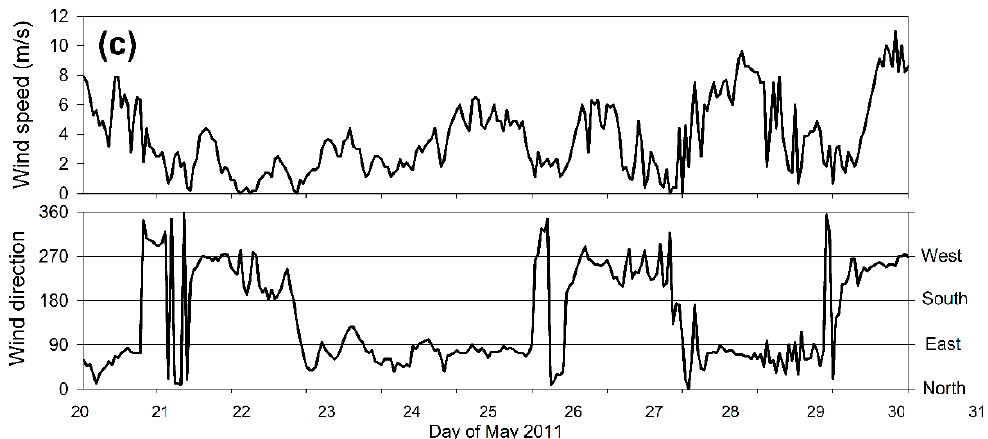
Figure 1. ( a ) Sea surface temperature (SST; weekly, composed 23–30 May 2011). North-western Alboran upwelling (NWAU), western (A1) and eastern (A2) anticyclonic gyre, and mean position of the isohaline 37.5 [39], indicating the haline signal of the Almeria–Oran front (AOF), the most probable geostrophic current profiles [32,37] showing strong currents from Almeria to Oran associated with the AOF, site of community importance (SIC) Sur Almeria, and the proposed enlargement of the marine protected area (MPA). ( b ) Sampling area, sampling station, and main bathymetric features (Cape of Gata Canyon, Garrucha Canyon, and Abubacer High) SIC Sur Almeria coastal MPA in law and proposed enlargement of the MPA. ( c ) Wind velocity and direction during the sampling period [40]. The coordinate system of all maps in the present work is the World Geographical System (WGS) 1984 Web Mercator (auxiliary sphere).